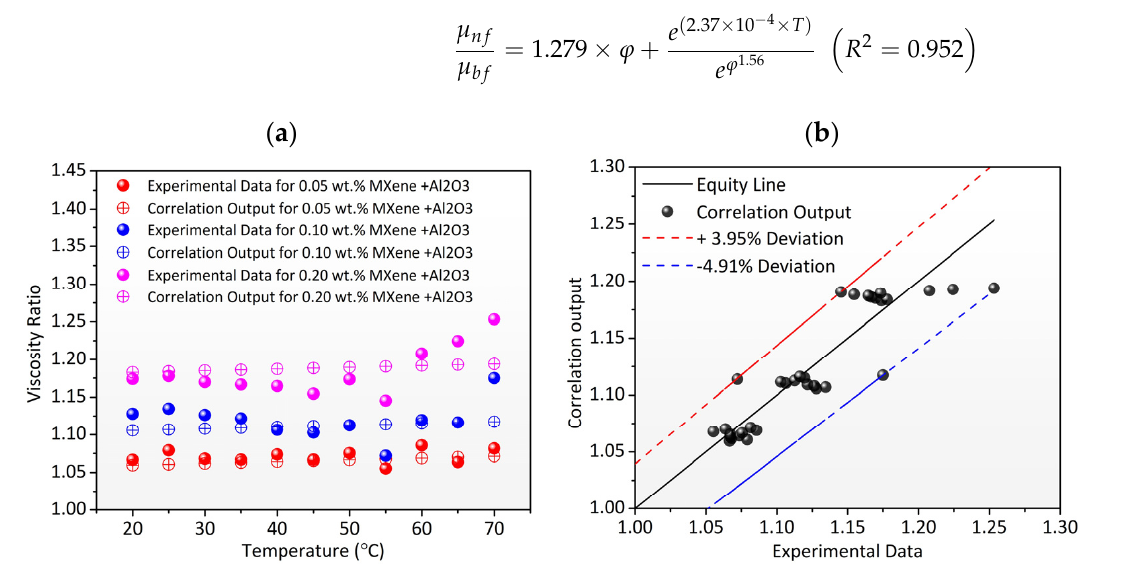
Figure 9. ( a ) Comparison between experimental viscosity ratio and correlation output as a function of temperature. ( b ) Correlation output vs. experimental viscosity ratio value with − 4.91 and 3.95% deviation lines.